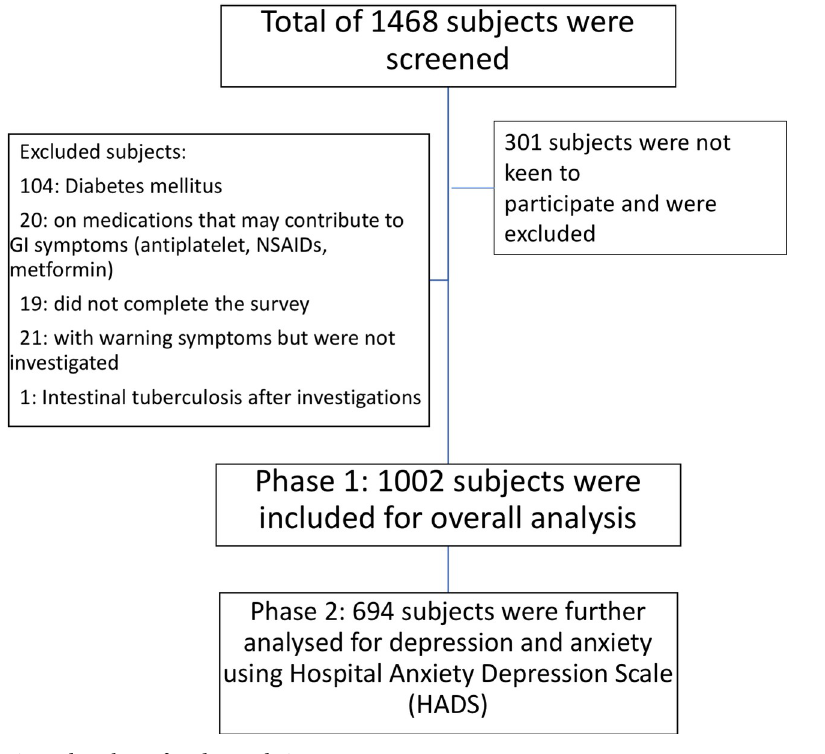
Fig 1. Flow chart of study